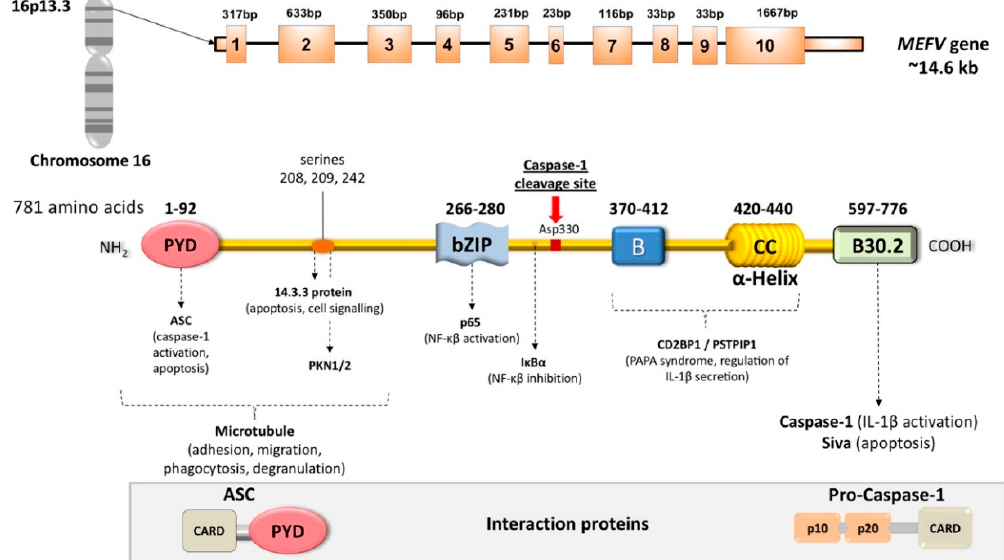
Figure 1. Schematic structure of MEFV gene and encoded pyrin (marenostrin) protein. The MEFV gene encodes for the pyrin protein (781 amino acids). The most common mutations in Familial Mediterranean Fever (FMF) are in exon 10 encoding the B30.2 domain. The most important interaction partners appear below the pyrin structure. ASC and Pro-Caspase 1 are also drawn. Pyrin structure includes five di ff erent domains, each one responsible for protein-protein interaction, and each domain has a role in the regulation of innate response. From left to right, PYRIN (PYD) domain (residues 1–92) interacts with ASC (apoptosis-associated speck-like protein containing a CARD—caspase-recruitment domain). bZIP transcription factor basic domain (residues 266–280) interacts with the p65 subunit (transcription factor p65) of NF- κ B, and I κ B- α . The B-box zinc finger domain (residues 375–412) and α -helical (CC, coiled-coil) domain (residues 420–440) likely influence the oligomerization of pyrin, and interact with the PAPA protein (also named PSTPIP1, proline serine threonine phosphatase-interacting protein, also known as CD2BP1 involved in the organization of the cytoskeleton) and the regulation of IL-1 β secretion. The B30.2 domain (PRYSPRY) (residues 597–776) is the most important, and interacts with caspase-1 and the proapoptotic protein Siva. Further pyrin interactions include binding to microtubules (starting from the N -terminal to bZIP), interaction with 14.3.3 (14-3-3 protein), and with the PKN1/2 (serine-threonine kinases PKN1 and PKN2) at the three serine residues 208, 209, 242 between PYD and bZIP. The position of Asp330 between bZIP and the B-box indicates the caspase-1 cleavage site. Mutations in the B30.2 domain tend to be transmitted in